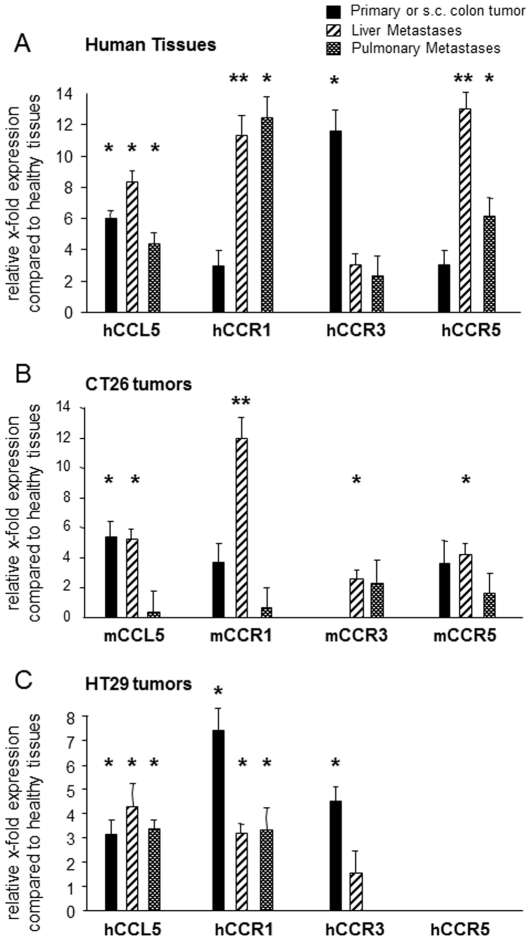
Expression of CCL5 and its corresponding CCR1, CCR3, CCR5 receptors in human biopsies and mouse tissues of colorectal carcinoma.Analysis of levels of expression of human (h) or mouse (m) targets was performed by quantitative RT-PCR in surgical resection pieces of human colorectal carcinoma (n = 10) (A), in experimental subcutaneous tumors (n = 6), liver (n = 6) and lung metastases (n = 6) derived from mouse CT26 cells (B) or derived from human HT29 cells (C) compared with corresponding healthy tissues (normal human, n = 10, and normal mouse colon, n = 6, respectively). The relative levels of expression were calculated using standard curves and expressed as 1/ΔCt. ΔCt values were calculated by substracting Ct of normalizing gene from Ct of target gene, measured in the same RNA preparation. Comparative level of mRNA expression between healthy (X) and metastatic tissues (Y) was calculated using the formula ΔC
T
Y – ΔC
T
X and expressed as fold over healthy (2ΔΔC
T). Black bars: primary or subcutaneous colon tumors; hatched bars: liver metastases; dotted bars: lung metastases. * p<0.05, ** p<0.01.